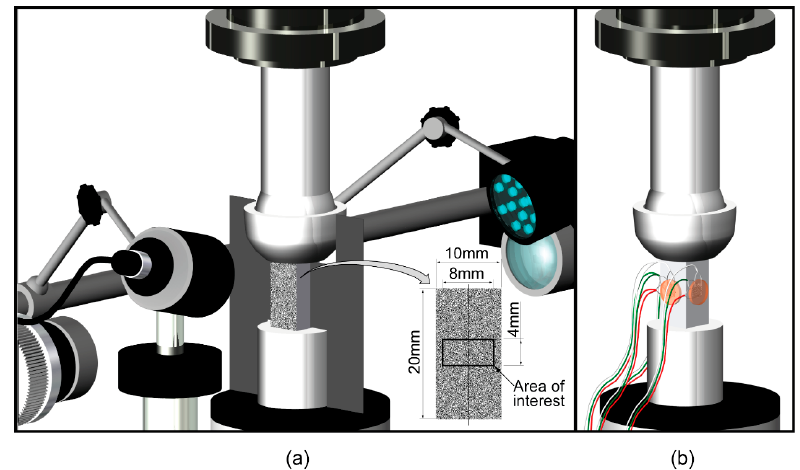
Figure 1. Scheme of the experimental setup used to measure surface strain. ( a ) Arrangement of the DIC system. The area of interest on the specimen surface is also shown. ( b ) Specimen instrumented with triaxial rosettes.